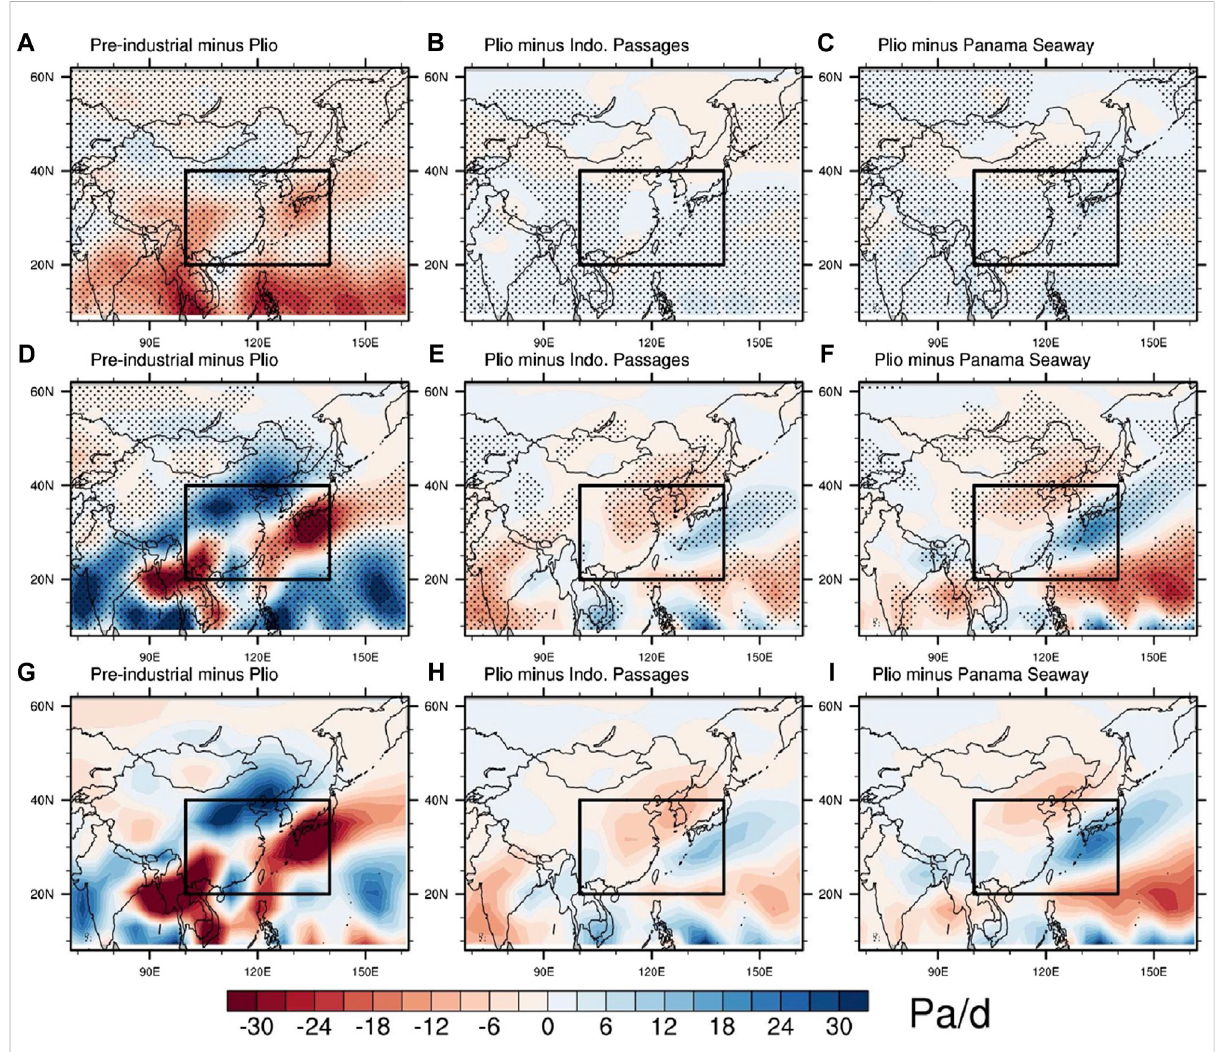
FIGURE 8 Decomposition of precipitation change as determined from the water vapor budget. Refer to the text for more details. (A) thermodynamic component in response to lower CO 2 , (B) the constriction of the IndonesianPassages and (C) the closure of the Panama Seaway. Stippling indicates thedifferencesforsurfacespeci fi chumidityaresigni fi cantatthe95%con fi dencelevelusingStudent ’ st-test. (D – F) sameasin (A – C) butfordynamic component. Stippling indicates the differences for vertical velocity are signi fi cant at the 95% con fi dence level using Student ’ s t-test. (G – I) summation of thermodynamic and dynamic component. The unit is